Question: Author a descriptive caption for the visualization shown.
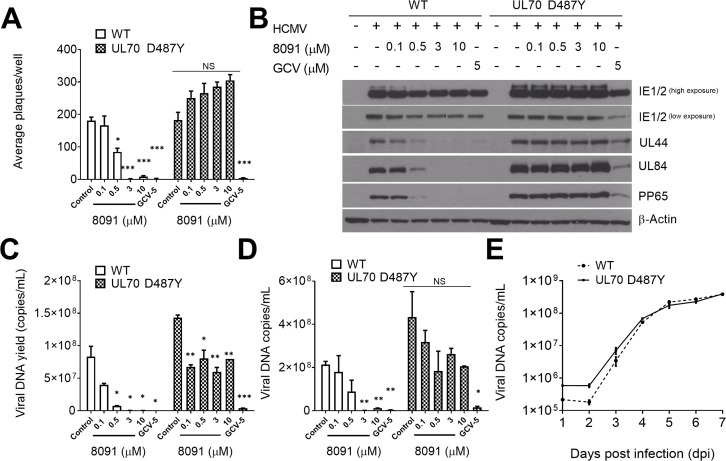
Answer: The point mutation in AD169 UL70 D487Y confers resistance to MLS8091 . ( A ) HFFs were infected with 200 PFUs of WT- or UL70 D487Y, and the activity of MLS8091 was measured by plaque reduction assay. ( B ) HFFs were infected with WT- or UL70-D487Y AD169 (MOI 0.1), and the expression of viral proteins IE1/2, UL44, UL84, and pp65 was measured 4 days post-infection. ( C ) HFFs were infected with WT- or UL70-D487Y AD169 (MOI 0.1), and viral load in the supernatants was measured by US17 real-time PCR at 4 days post-infection. ( D ) HFFs were infected with WT- or UL70-D487Y AD169 (MOI 0.1), and viral DNA was quantified in infected cell extracts at 48 hpi by US17 real-time PCR. NS- non-significant. ( E ) Growth Curve assay: HFFs were infected with WT AD169 or UL70 D487Y AD169 (MOI 0.1). Supernatants were collected post-infection from days 1 to 7, and viral load was quantified using US17 real-time PCR. Statistical significance is compared with the infected-only (control) group.